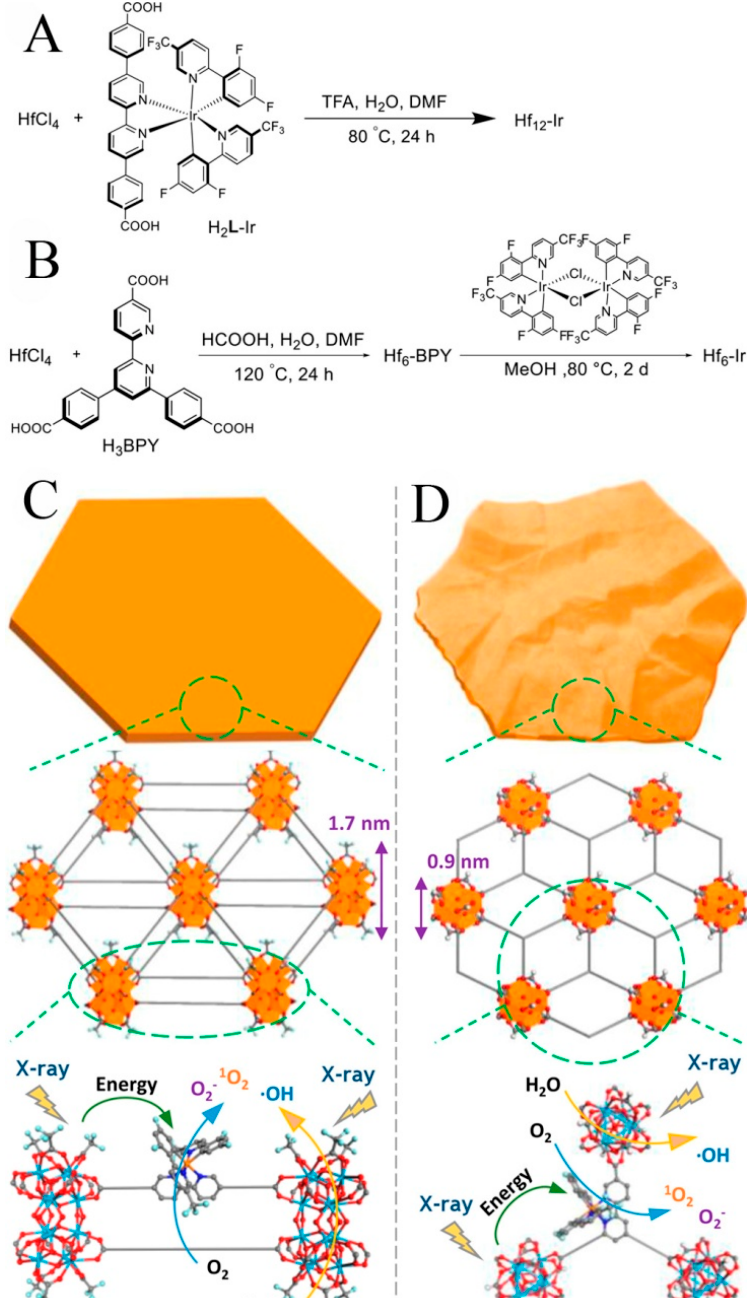
Figure 4. The synthesis methods, morphologies and structures of Hf 12 ‐ Ir MOF nanolayer ( A , C ) and Hf 6 ‐ Ir MOF nanolayer ( B , D ) and X ‐ ray induced ROS generation. Reprinted with permission from